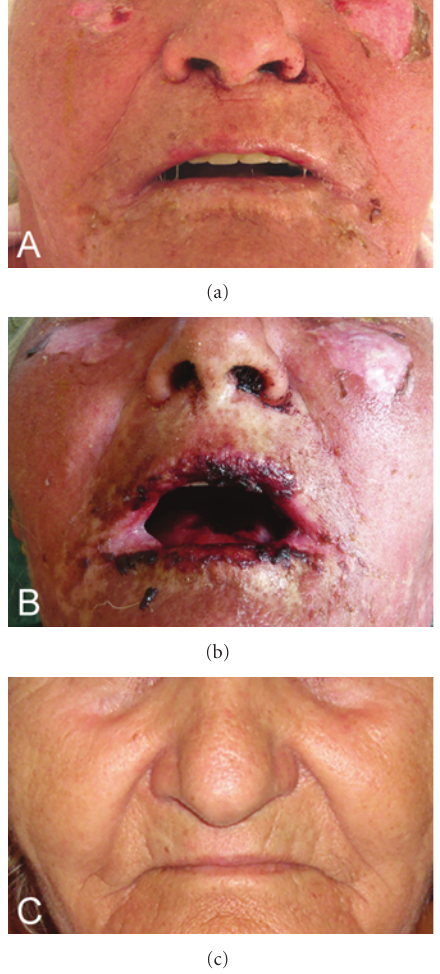
Figure 1: Detail of patient’s face. Panel (a): di ff use erythema and beginning of detachment of the epidermis at admission. Panel (b): at day 4 of hospitalization presence of hemorrhagic stomatitis and cheilitis, however with already arrested disease progression in the skin. Panel (c): state of complete recovery at 9-month follow-up